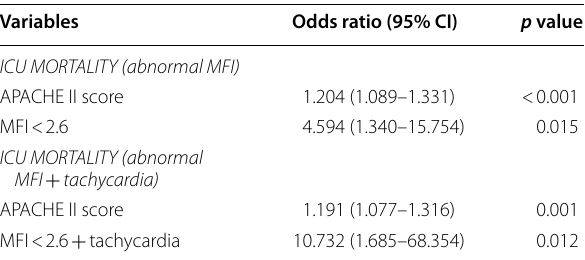
Table 2 Binary logistic regression analysis for ICU mortal-